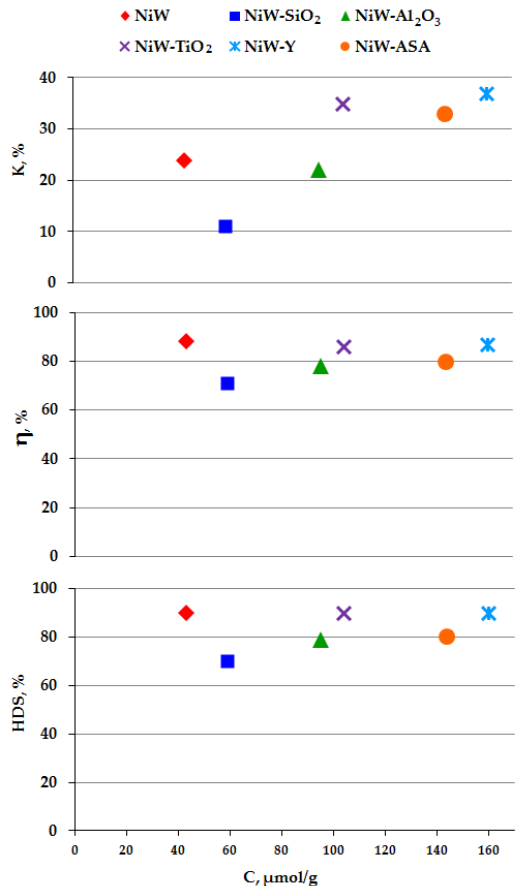
Figure 1. Dependence of the degrees of conversion (K), hydrodearomatization ( η ), and hydrodesulfurization (HDS) of VGO on the total concentration of acid sites (390 °C, 5.0 MPa, 5 h).